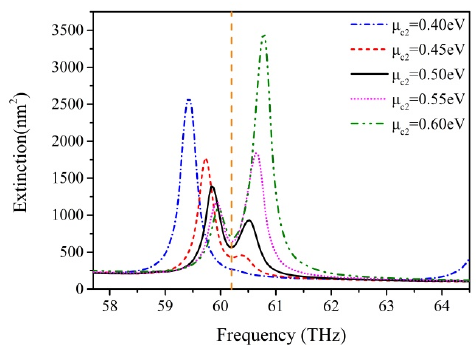
Figure 4. Extinction spectra of graphene with different chemical potentials of the central nanodisk µ c2 . The mode competition between central mode and ring mode is clearly visible with varying µ c2 . To shed light more light on the effect of the chemical potential of local graphene on whole graphene oligomers, we calculate the real part and the imaginary part of the effective refractive